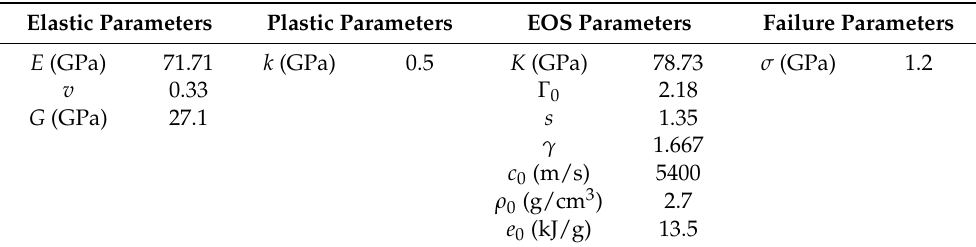
Table 2. Material properties of